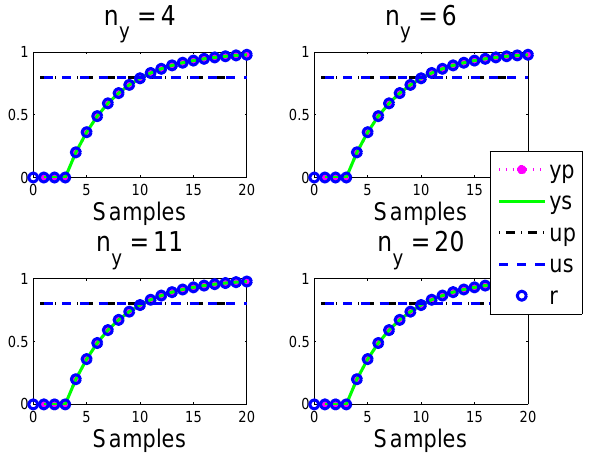
Figure 5. Closed-loop PFC input and output us; ys responses overlaid with predictions up; yp made at the first sample for a = (cid:26) ; here, ys = yp; us = up for system with a three-sample